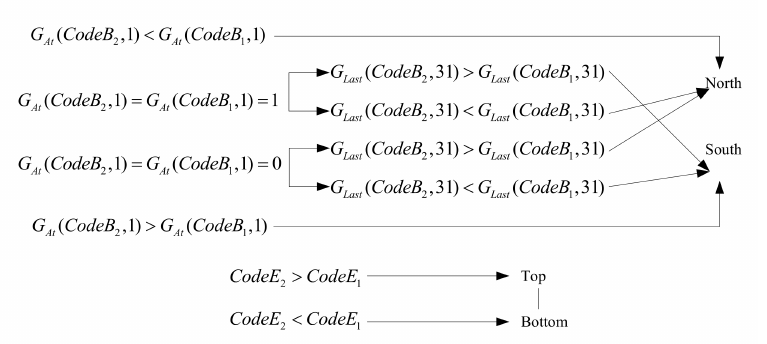
Figure 9. The calculation of grid spatial orientation